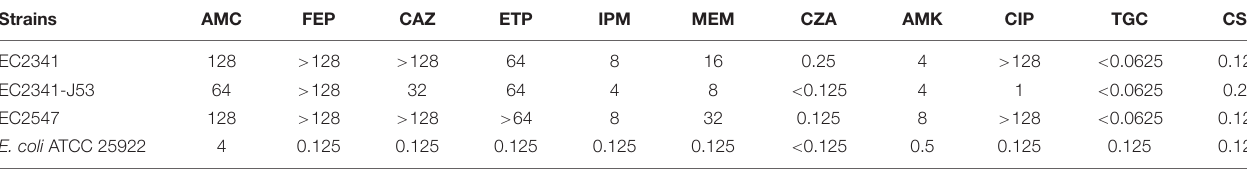
TABLE 1 | Antibiotic susceptibility used in this study (mg/L).